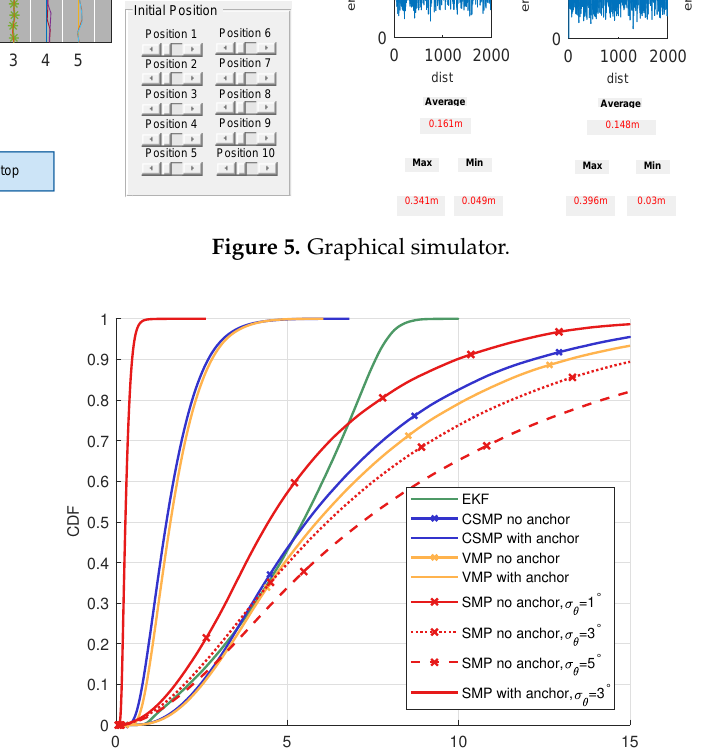
Figure 6. Performance comparison with various distributive